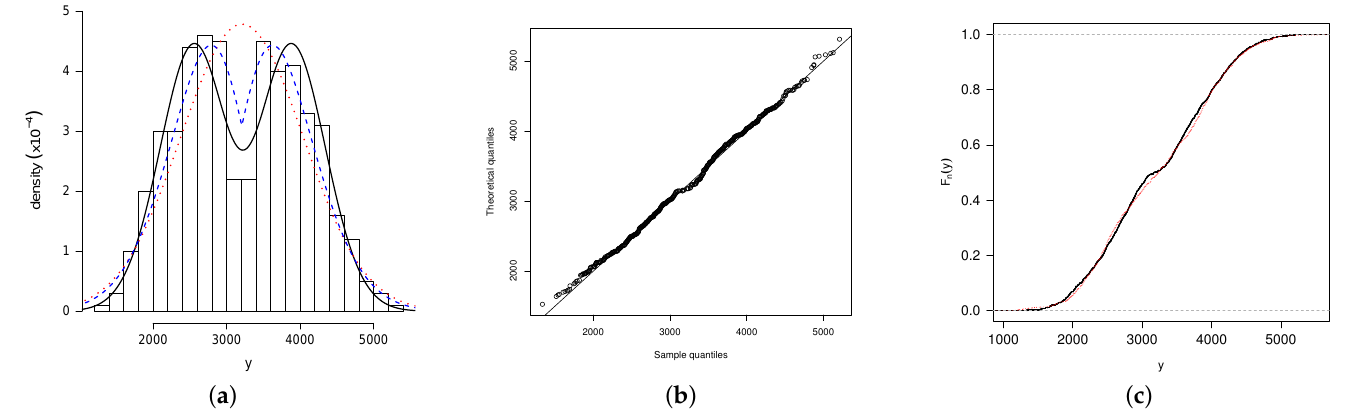
Figure 4. ( a ) Histogram for the variable birthweight. Estimated pdf: N (dotted red line), TN (dashed blue line) and BESN (solid black line). ( b ) QQ-plot for the BESN distribution. ( c ) Empirical cdf for the variable birthweight (solid black line) and cdf of the BESN distribution (dotted red line).